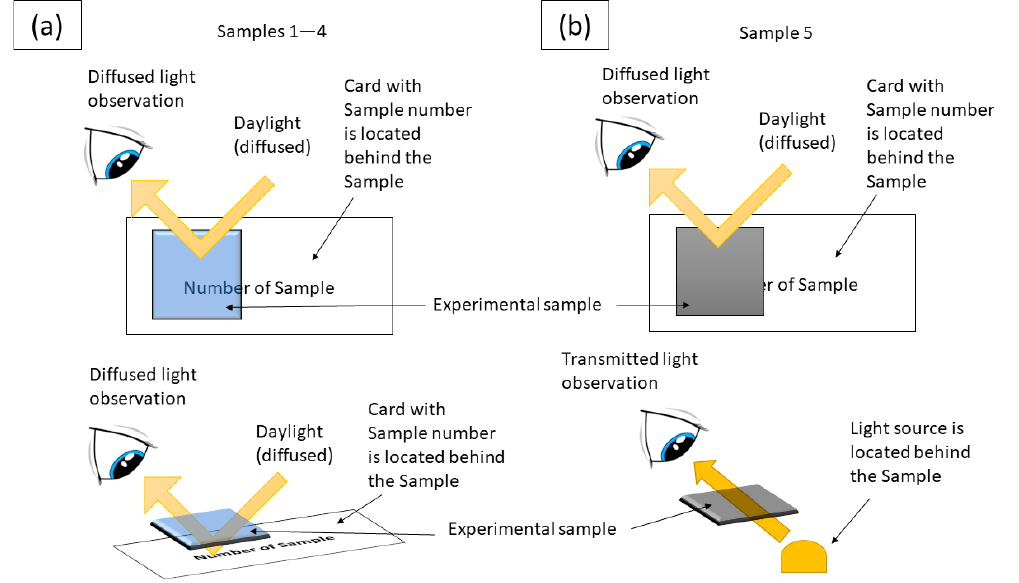
Figure 2. Schematic representation of experiments to evaluate the visual transmission of semi-trans- parent ( a ) and almost non-transparent ( b )